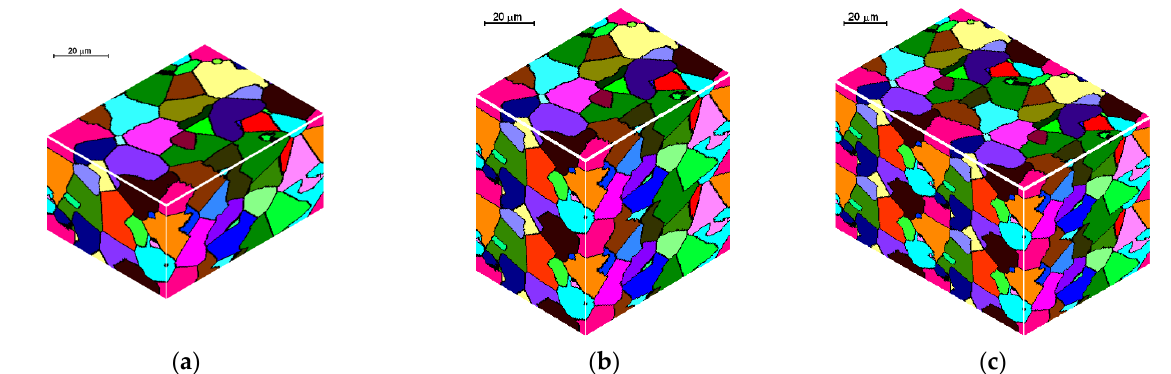
Figure 14. Example of space doubling: ( a ) initial structure, ( b ) structure after the doubled in the vertical direction, ( c ) structure after the doubled in the vertical and horizontal directions.